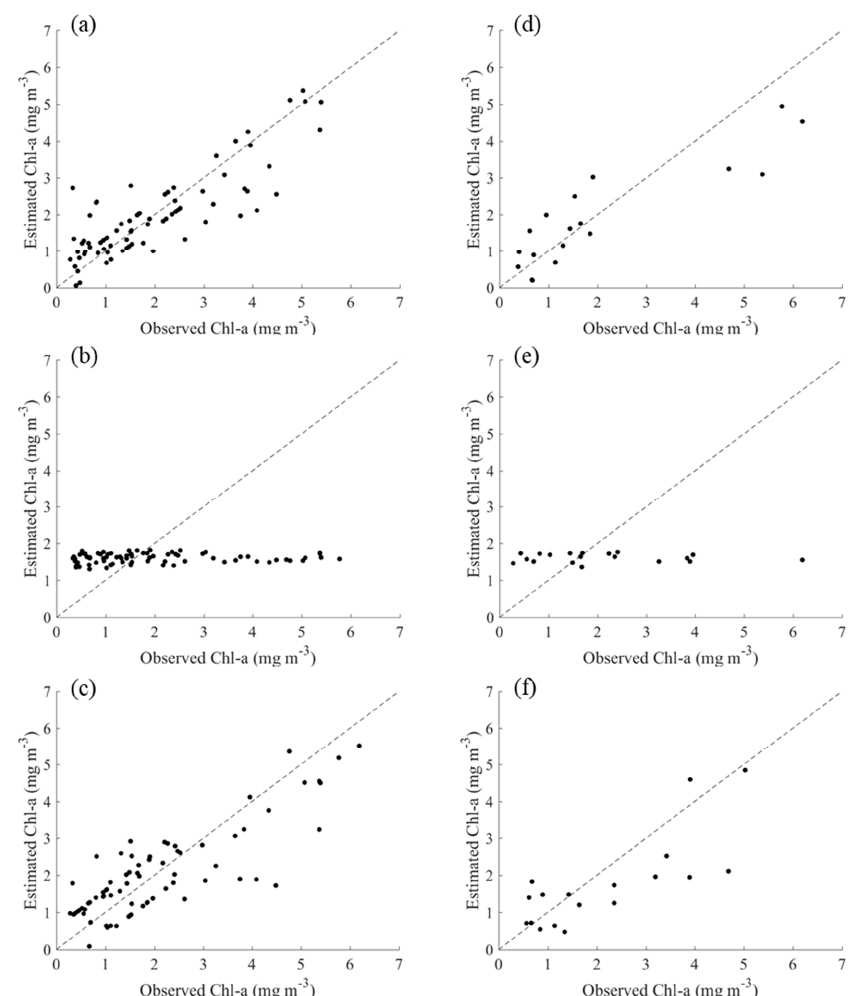
Figure 5. Scatter plots of in situ and estimated chl-a for the SVR model using the Gaussian radius bias kernel. ( a ) the training results for the four-band, ( d ) the validation results for the four-band, ( b) the training results for the four-band-ratio, ( e ) the validation results for the four-band-ratio, ( c ) the training results for mixed dataset ( f ) the validation results for mixed dataset. In addition, distribution maps of chl-a, created using machine learning models, are shown in Figure 6. From the raw Landsat-8 image, the ANN and SVR models were applied and chl-a maps were developed. For the raw images, a total of three images, 3 August, 12 August, and 13 September